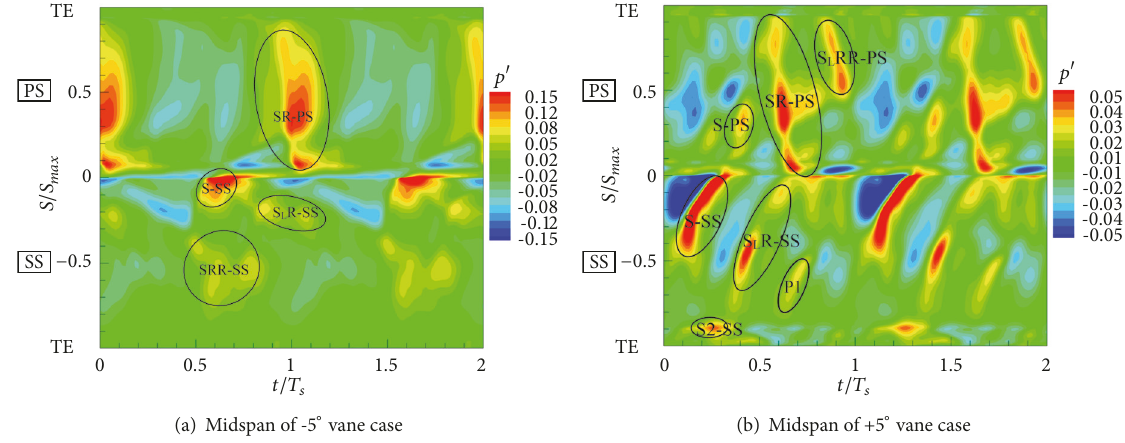
Figure 9: Space-time plots of the unsteady pressure for the VGT at